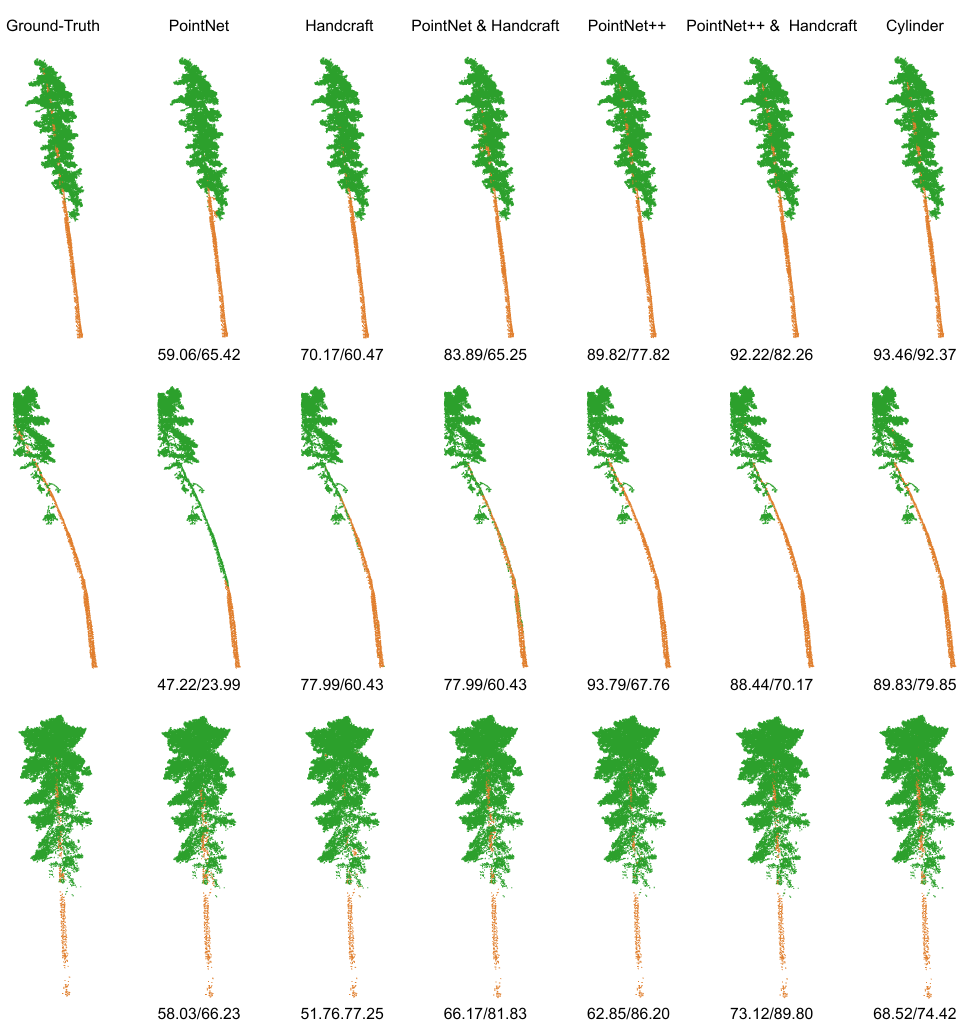
Figure 7. Visualisation of ground-truth stem and foliage points as well as those predicted by the different semantic segmentation methods. We use three different trees from the Tumut dataset as an example and we include the IoU O./IoU Seg. for each method and each tree. Best viewed in